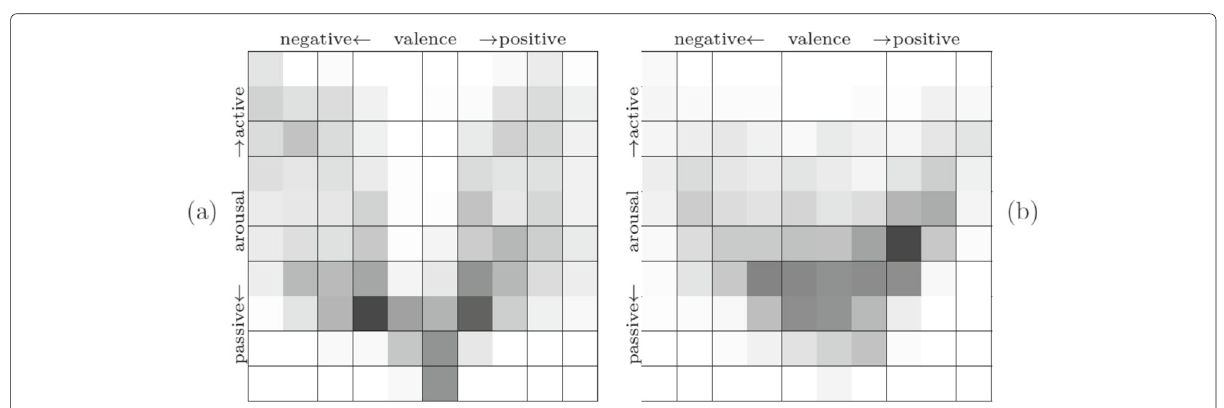
Fig. 7 Joint valence-arousal histograms for a intended and b expected emotion ( darker signifies higher